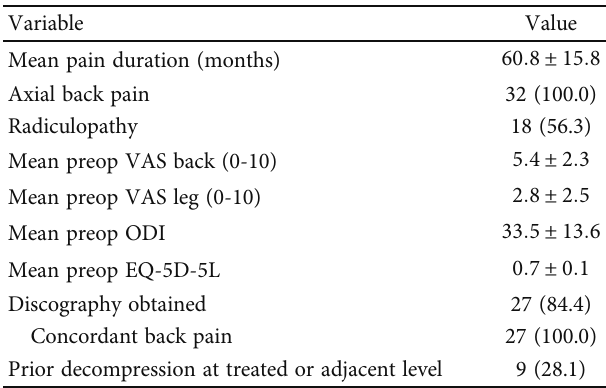
Table 2: Preprocedural details.